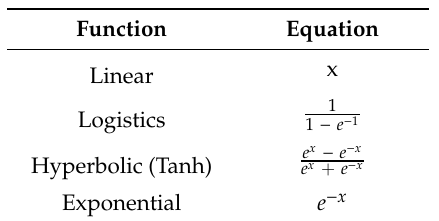
Table 1. Activation functions applied at the network learning